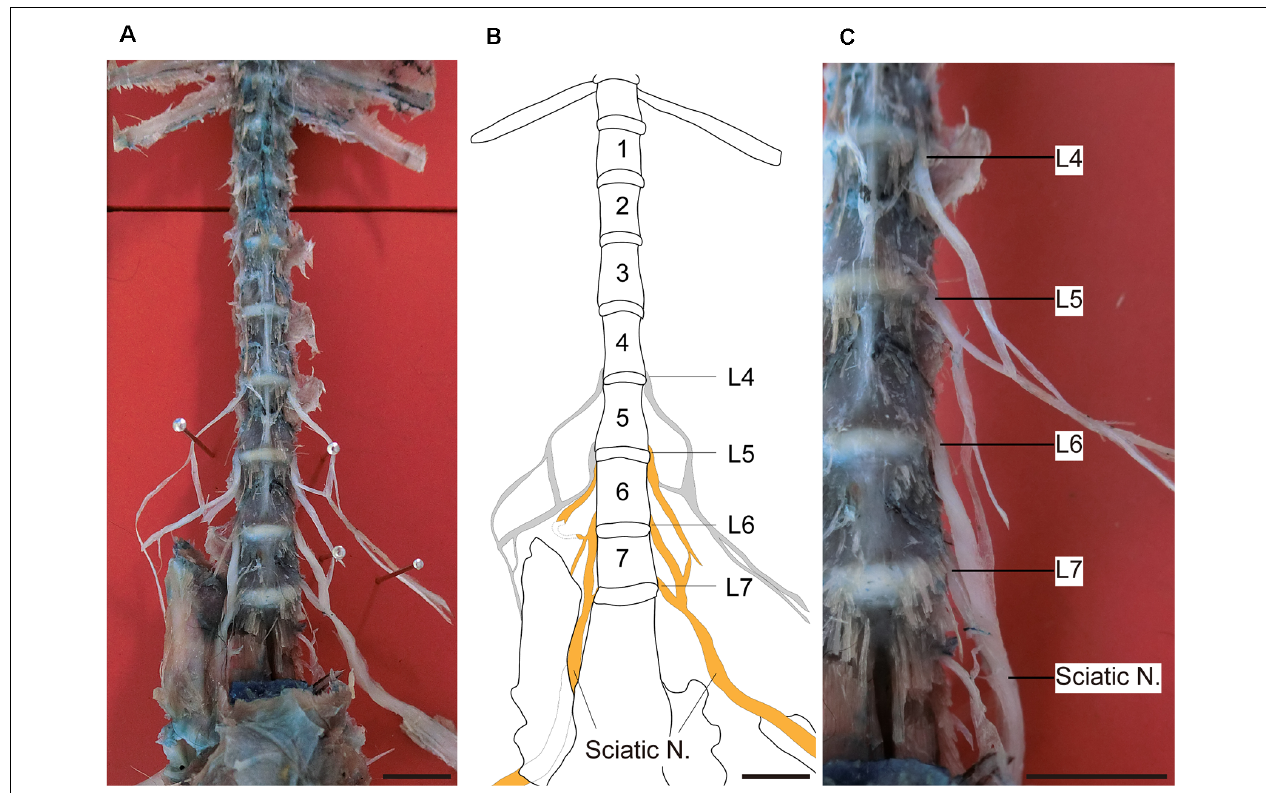
FIGURE 1 | Sciatic nerve and DRGs of marmosets. Ventral views of the dissection and reference line drawing made from a marmoset, showing the sciatic nerve and its segmental origins. (A) Photograph showing the lower thoracic and lumbar spinal cord. The sciatic nerve is formed by the combination of several nerves in the lumbar spine. (B) A line drawing of the photograph shown in (A) . The lumbar region of this specimen contained seven vertebrae. The L5, L6, and L7 spinal nerves contributed to the sciatic nerve. Gray lines: nerves hidden by the overlying pelvic bone. (C) Right side of the lower lumbar vertebrae as shown in (A) (enlarged). Orange: sciatic nerve. Scale bars: 10